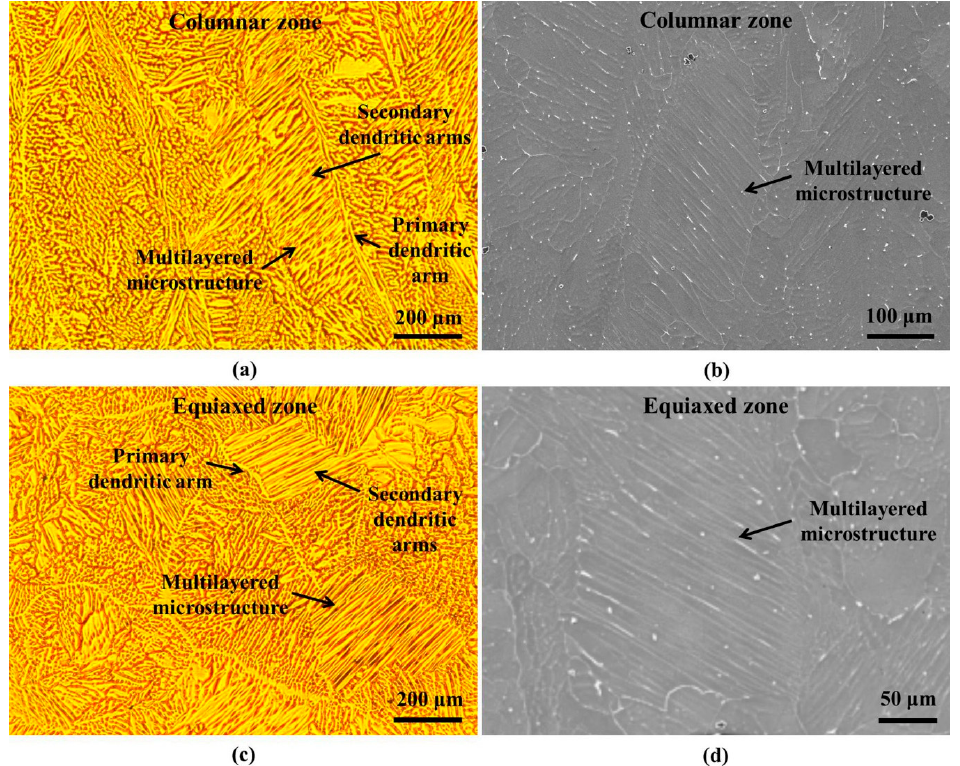
Figure 5. Primary and secondary dendritic microstructure in TW-B0: ( a , c ) optical micrographs and ( b , d ) SEM micrographs.